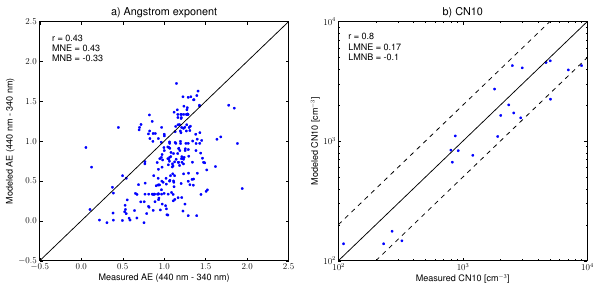
Fig. 4. Scatter plots comparing modelled (BASE solar maximum) to measured Angstrom Exponent (panel a ) and CN10 (panel b ). Loca- tions for comparison are shown in Fig. 3. The correlation coefficient ( r ), log-mean normalized error (LMNE) and log-mean normalized bias (LMNB) are shown in the upper left hand corner.